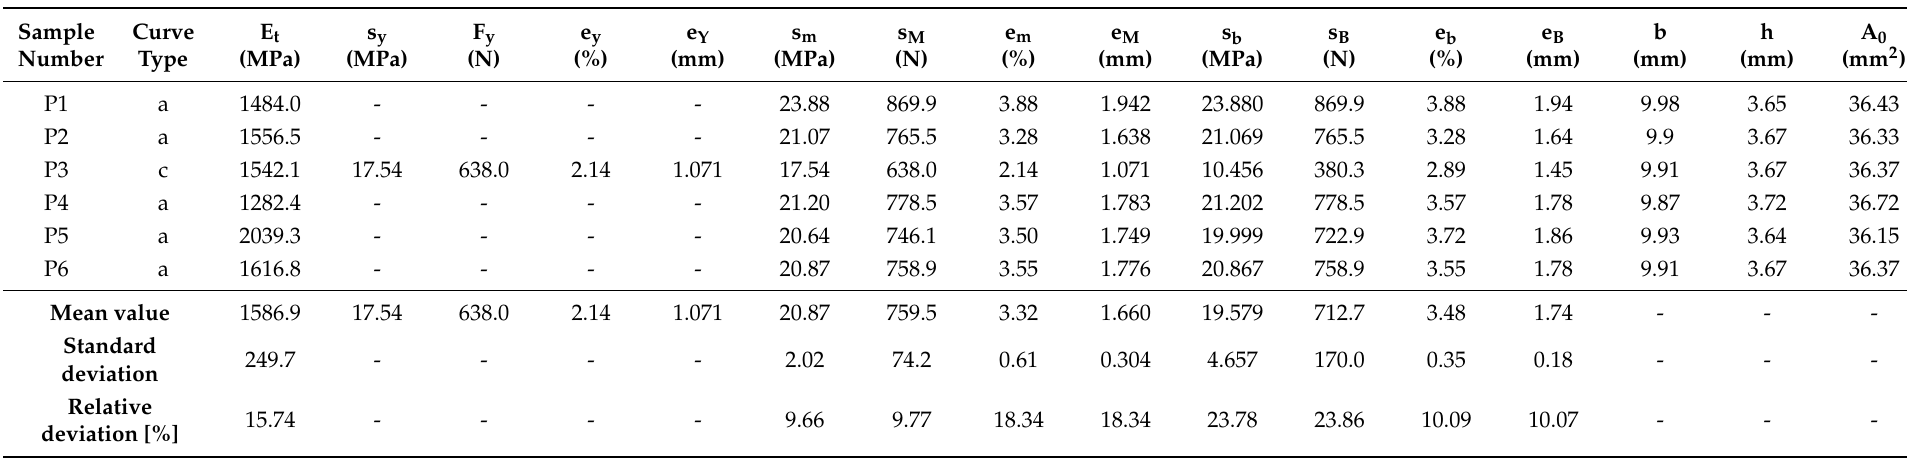
Table A33. Results of the tensile tests of